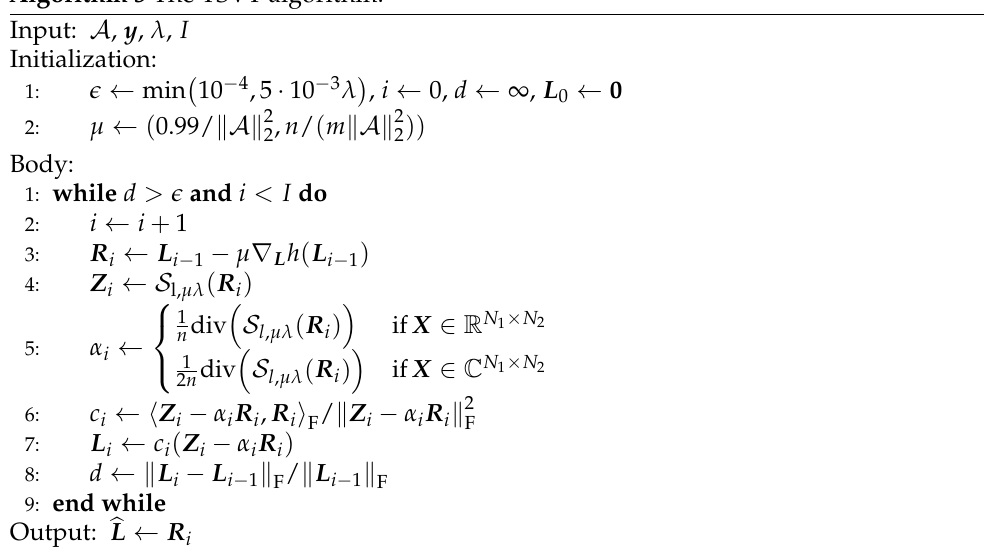
Algorithm 3 The TSVT